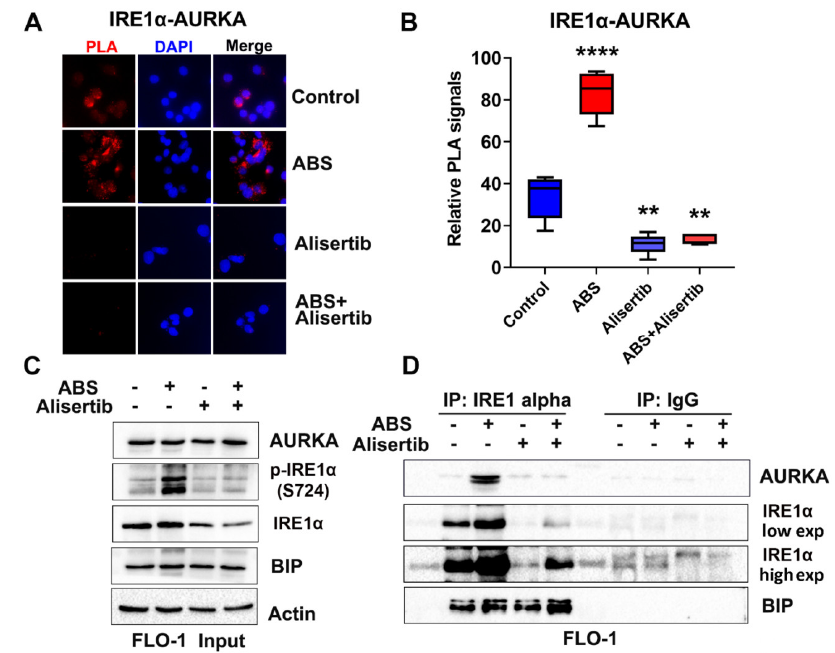
Figure 5. AURKA binds to IRE1α in ABS exposure. ( A ) In situ proximity ligation assay (PLA) immunofluorescence staining in FLO-1 control cells or alisertib 200 nM 48 h pretreated cells with or without ABS (pH 4.0, 200 μM, 20′) exposure. The red signal indicates the positive PLA signal. 200x magnification. ( B ) Quantification of positive PLA signal (red signal) in ( A ) using ImageJ software. ( C ) Western blot analysis of AURKA, p-IRE1α (S724), IRE1α, BIP, and β-actin protein expression in FLO-1 AURKA IP input samples. Cells were treated with alisertib 200 nM 48 h, followed by ABS (pH 4.0, 200 μM, 20′) exposure. ( D ) Western blot analysis of AURKA, IRE1α, and BIP protein expression in AURKA IP or IgG IP samples from C. ** p < 0.01, **** p < 0.0001.